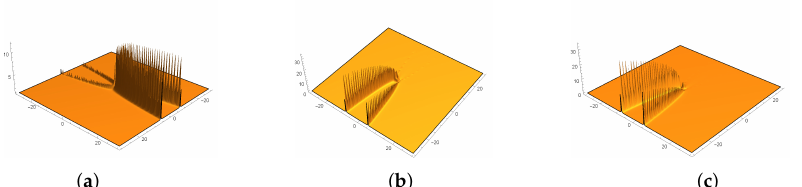
Figure 9. ( a – c ) are the first-order rational soliton solution via Equations (26a)–(26c) with ρ = 1, φ = 0, c 1 ( z ) = 0, c 2 ( z ) = z 2 and γ 1 = 1 − 0.1 i , respectively.